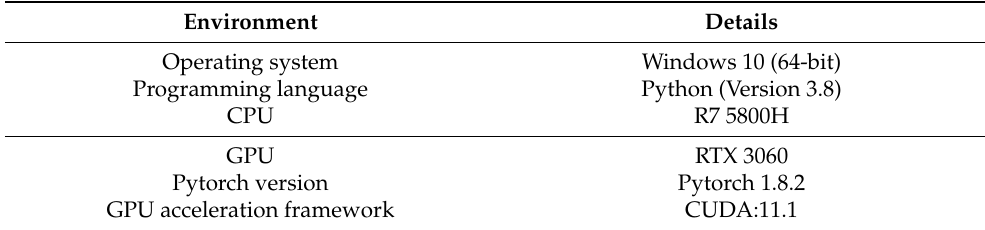
Table 1. Experimental experiment.